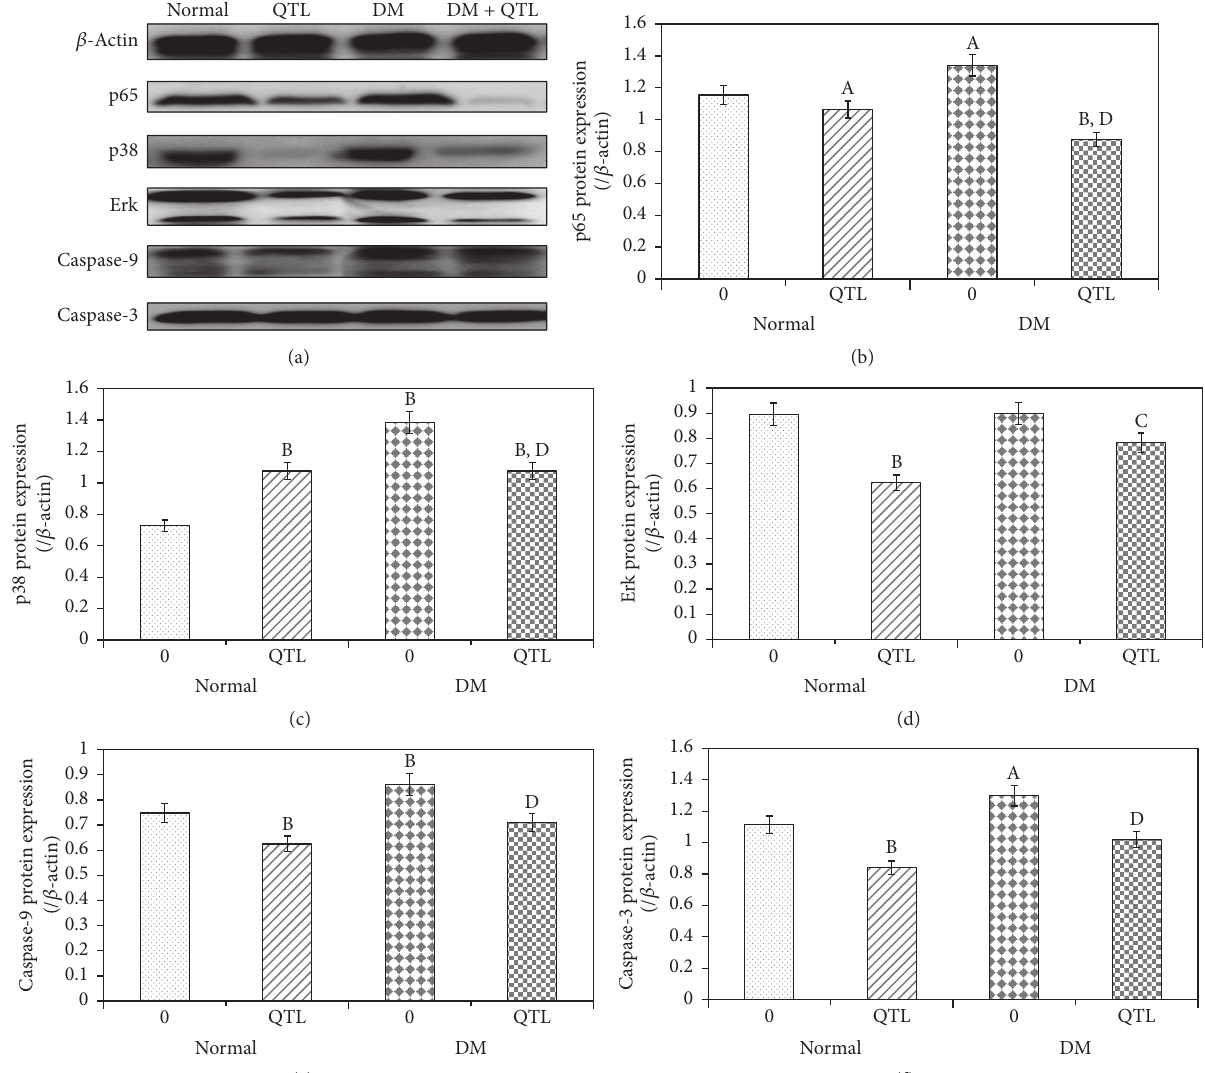
Figure 5: p65, p38, ERK, caspase-9, and caspase-3 proteins expression analysis in the liver of normal and diabetic mice . Density values were normalizedto 𝛽 -actinlevels.Datarepresentthemean ± SDfromthreeanimalsineachgroup. A 𝑃 < 0.05 comparedtocontrolgroup; B 𝑃 < 0.01 compared to control group; C 𝑃 < 0.05 compared to diabetic group; D 𝑃 < 0.01 compared to diabetic